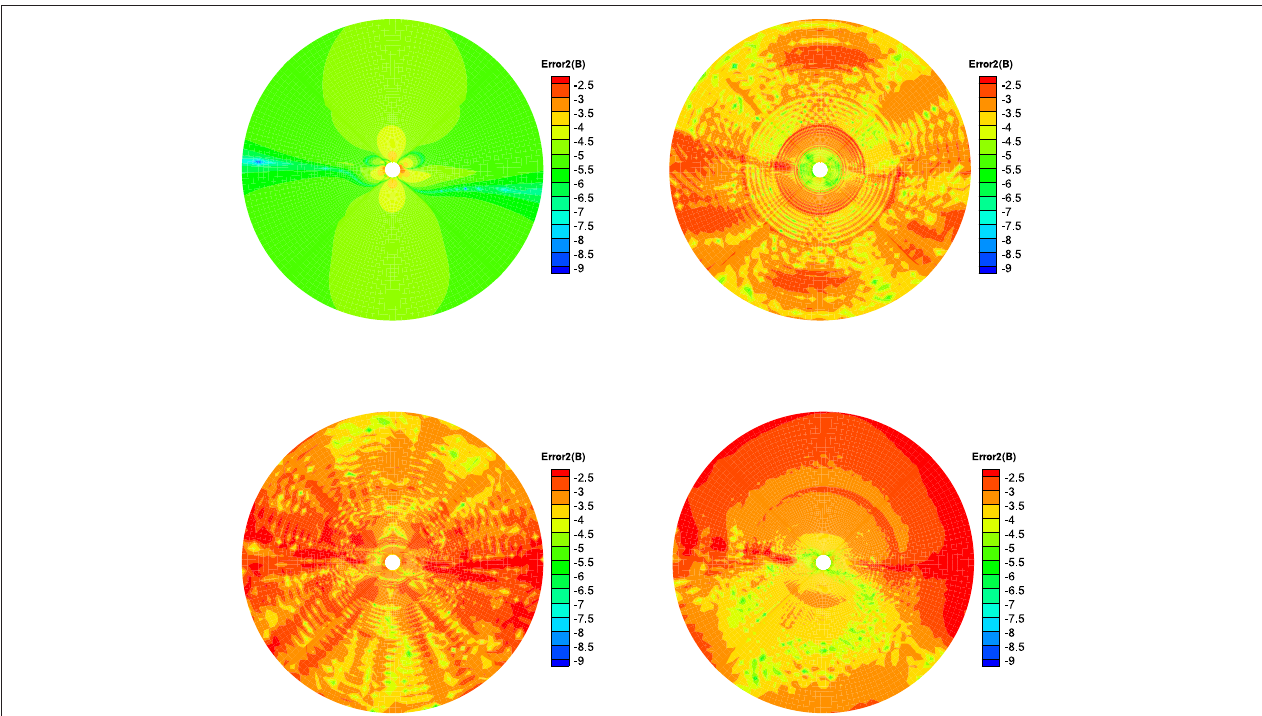
FIGURE 11 | The log 10 Error2 (B) in the calculation at t = 20 h on the meridional plane of φ = 180 ◦ − 0 ◦ from 1 to 20 R s , the results from CT method (left) and diffusive method (right) are displayed in the top row, the bottom row is produced from the projection method (left) and GLM method (right).